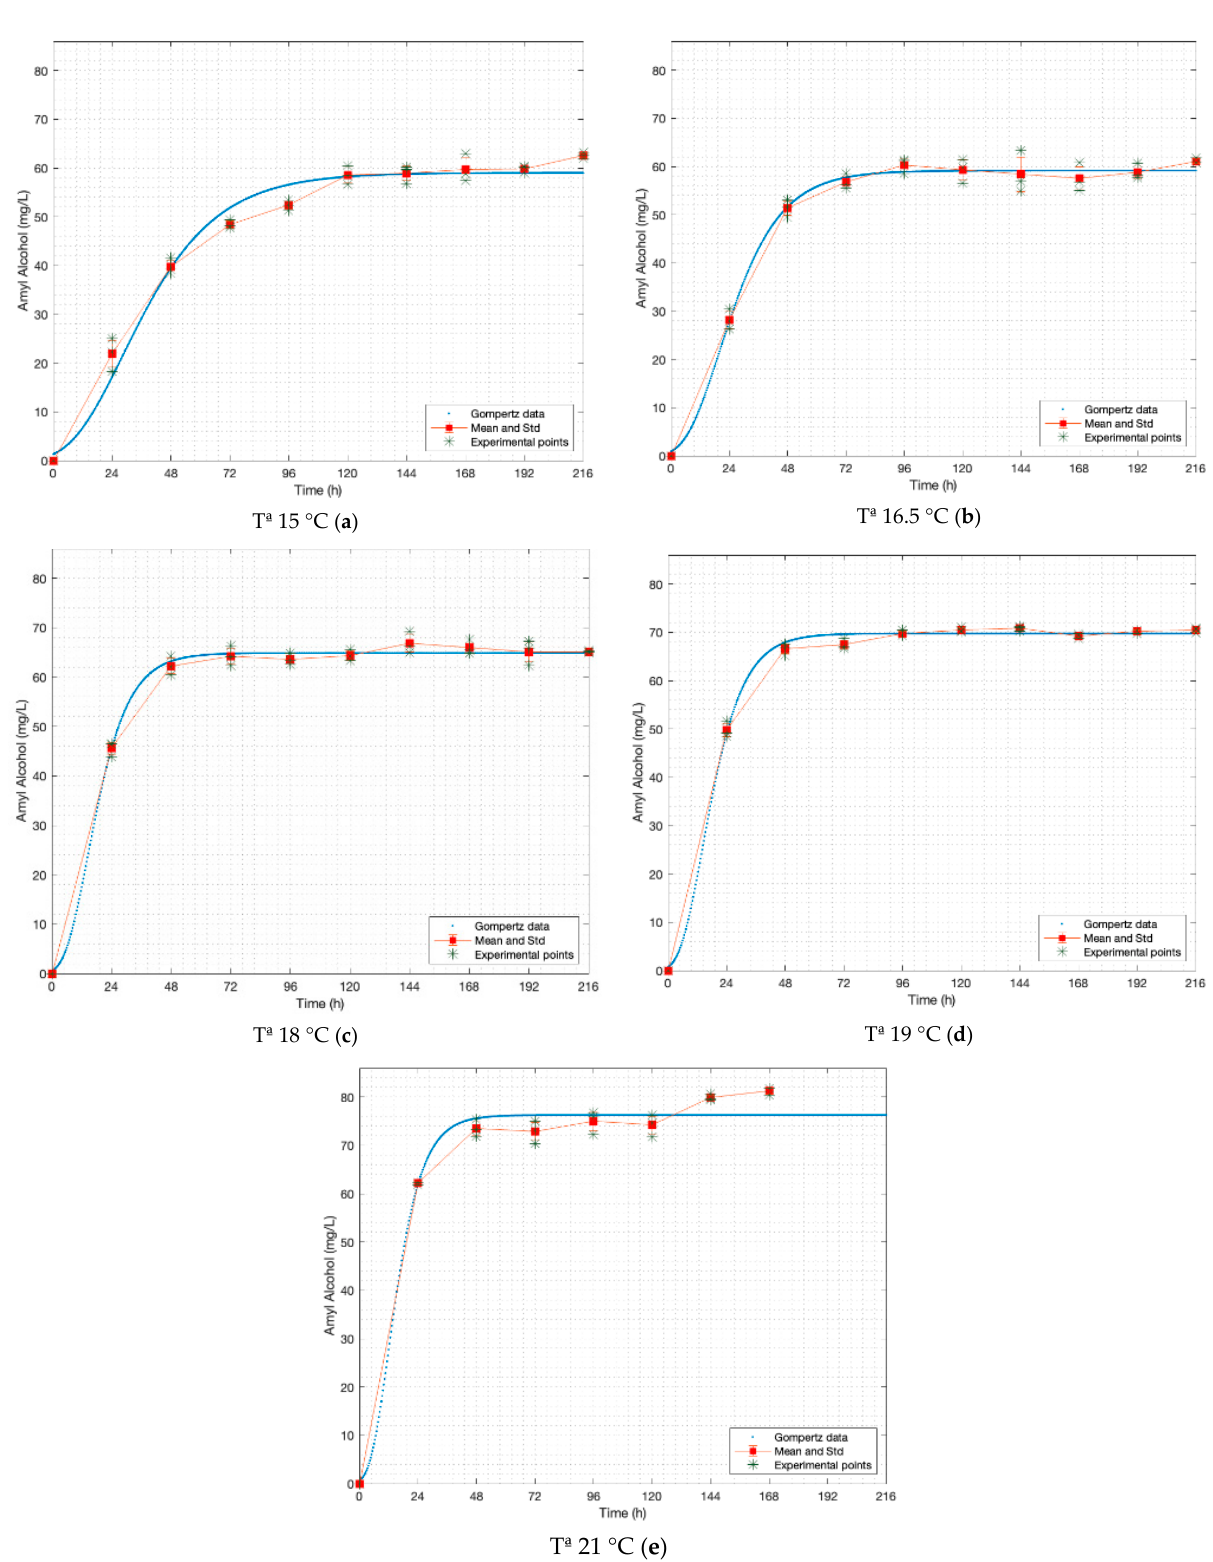
Figure 4. Gompertz graphs of predicted values for amyl alcohol. ( a ) Dataset 15 ◦ C; ( b ) dataset 16.5 ◦ C; ( c ) dataset 18 ◦ C; ( d ) dataset 19 ◦ C; ( e ) dataset 21 ◦ C. Blue lines represent the Gompertz function. Asterisk represents experimental raw data. Squares and red lines represent the means and standard